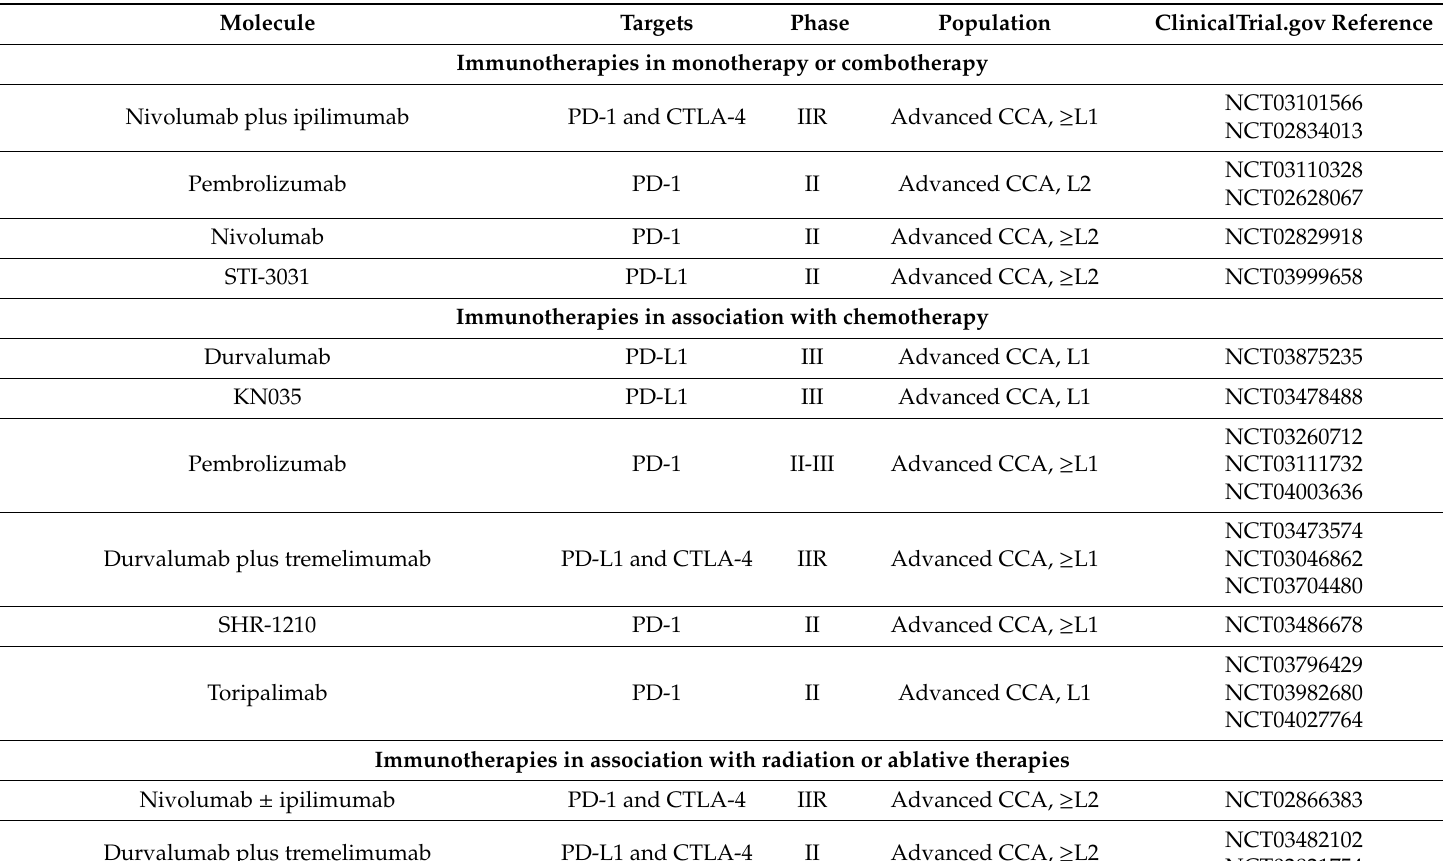
Table 3. Ongoing phase II or III trials evaluating immune therapies in biliary tract cancer 1